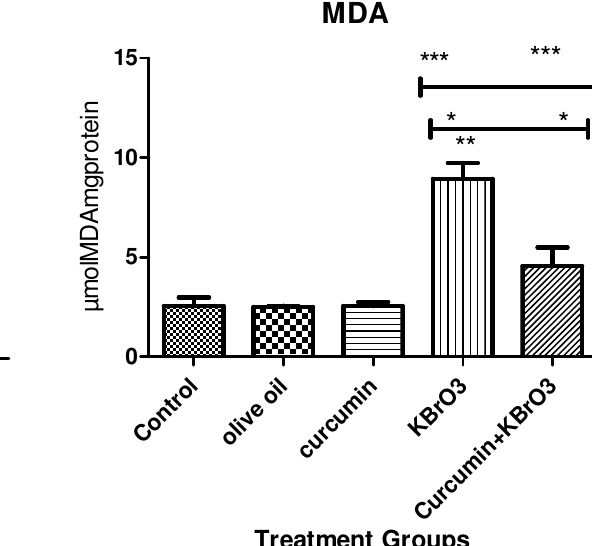
Fig. 5. Effect of curcumin on the activities of glutathione peroxidase (GPx) in KBrO3-induced liver oxidative damage. Data are presented as the mean ± SD (n = 6). * values are significantly (p<0.05) different from control, **values are significantly (p<0.05) different from curcumin+ KBrO ***values are significantly (p<0.05) different from curcumin. For details, see legend in Table 1